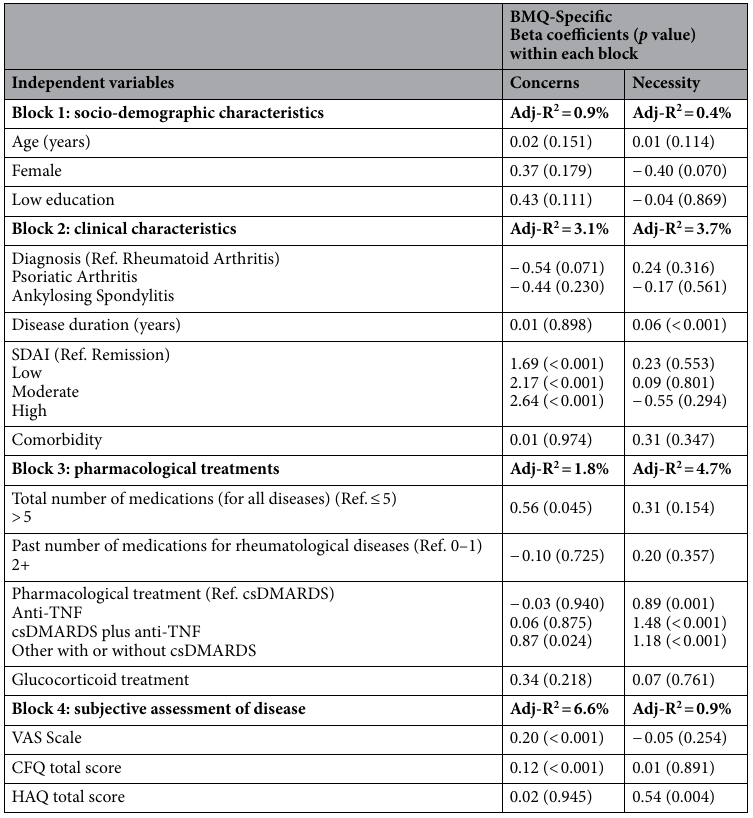
BMQ-Specific Beta coefficients ( p value) within each